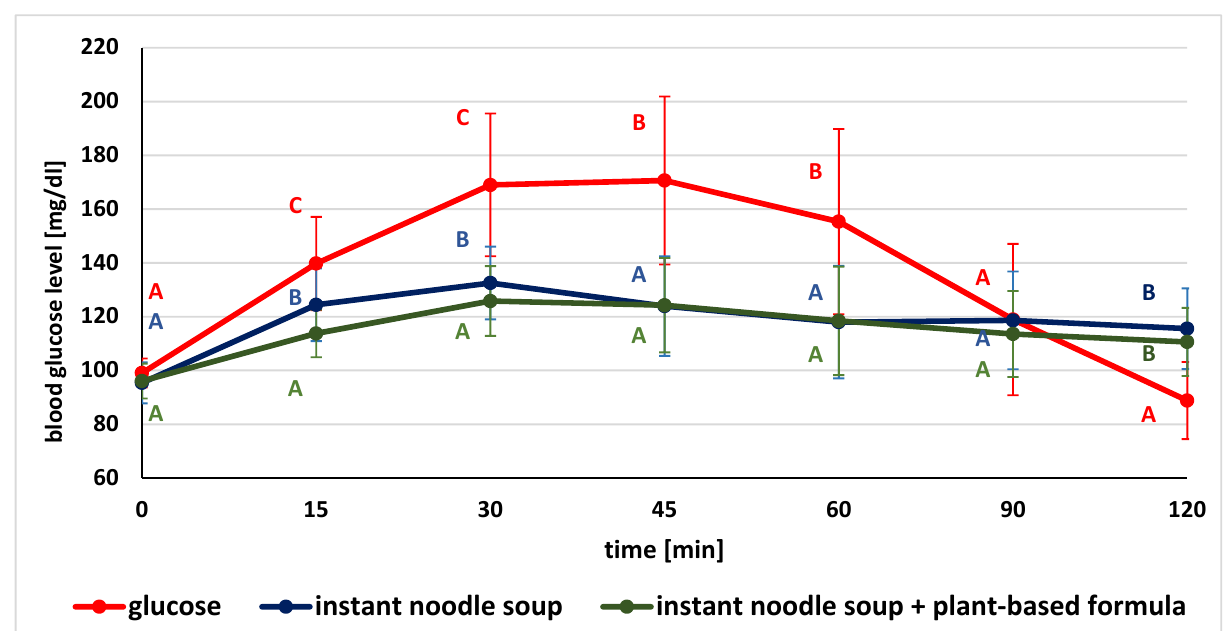
Figure 2. Comparison of mean blood glucose level after consumption of standard glucose solution and instant noodle soup without and with plant-based formula (for variables with the same letter, the difference is not statistically significant; error bars represent standard deviation, p > 0.05; one-way repeated-measures ANOVA).